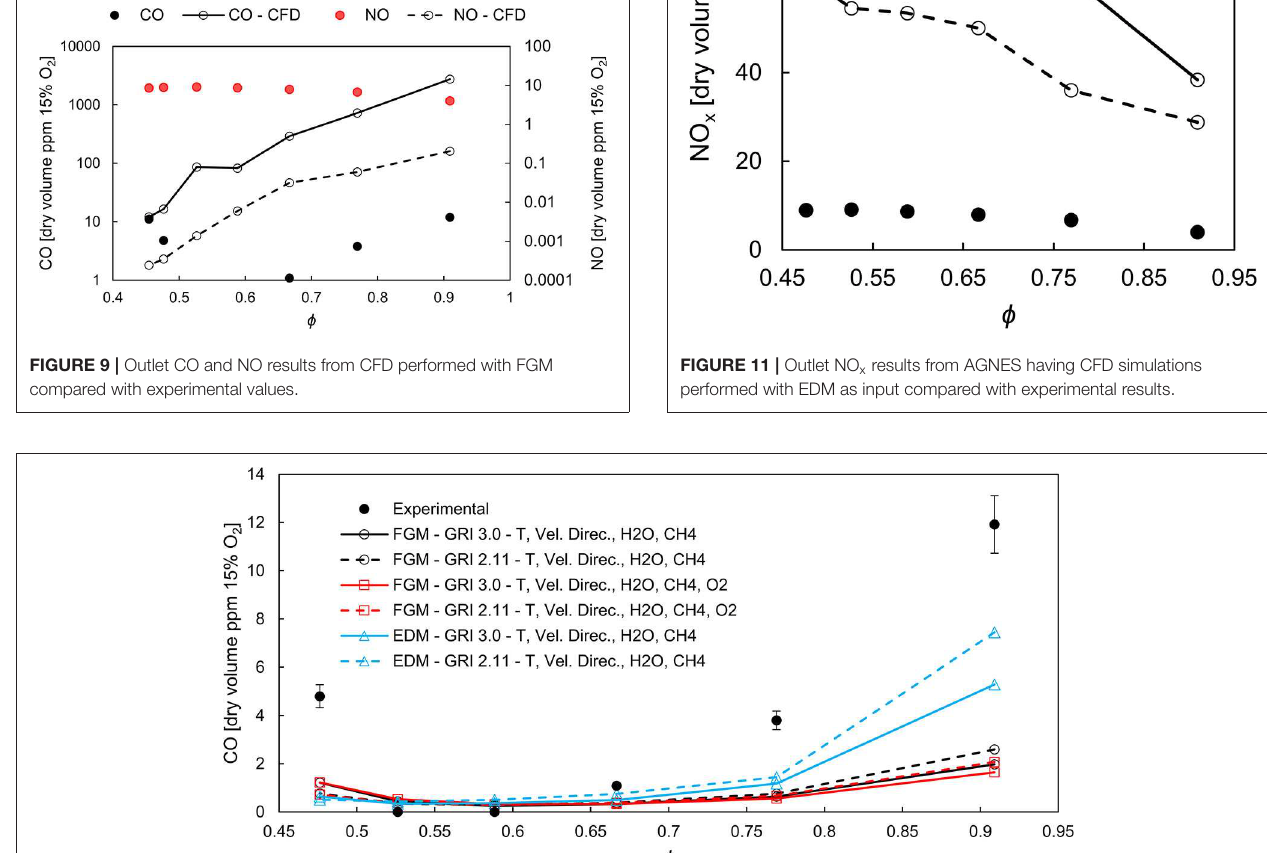
Frontiers in Mechanical Engineering |